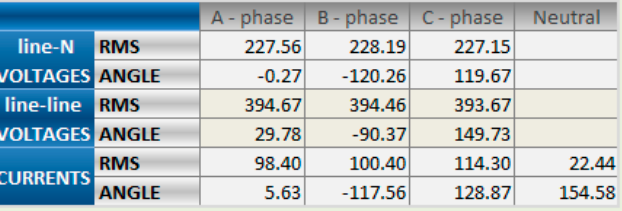
Figure 12. Voltages and currents calculated by the EPC software at the point of common coupling (PCC) of the residential distribution